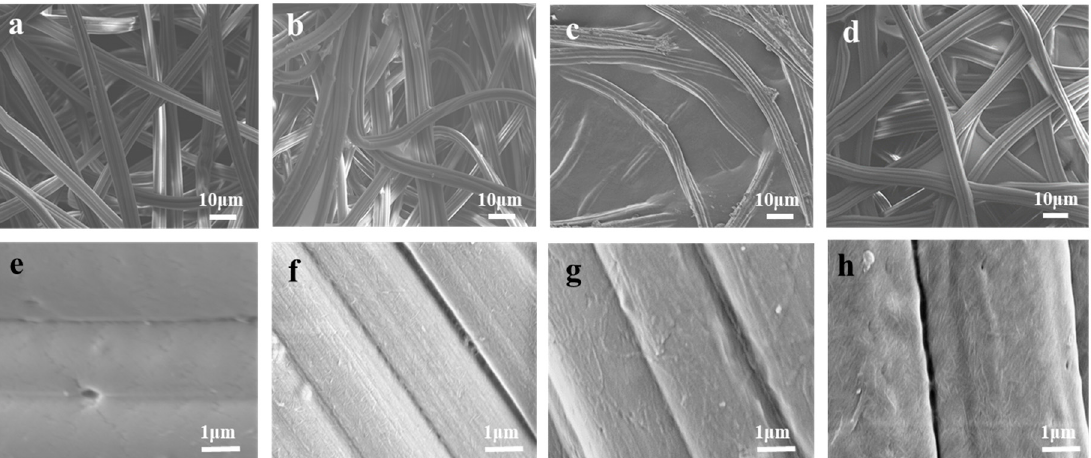
Figure 1. SEM images of unmodified and nonwoven fabrics after the coating process. ( a ) Surface of cellulose unmodified fabric, ( b ) surface of CNC impregnated fabric, ( c ) surface of T-CNF impregnated fabric, ( d ) surface of ChNC impregnated fabric, ( e ) surface of cellulose unmodified fibers, ( f ) nanotextured surface of CNC impregnated fibers, ( g ) nanotextured surface of T-CNF impregnated fibers, and ( h ) nanotextured surface of ChNC impregnated fibers. Unmodified cellulose nonwoven fabrics had a hydrophobic contact angle of 106.37 ± 2.73 ◦ , whereas for coated fabrics the values were much lower reaching 68.24 ± 3.68 ◦ for